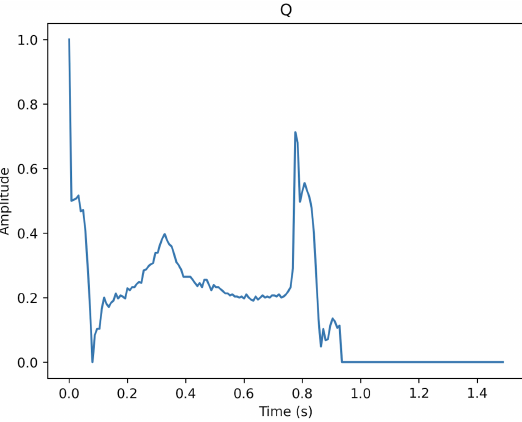
Figure 5. The description of class Q.